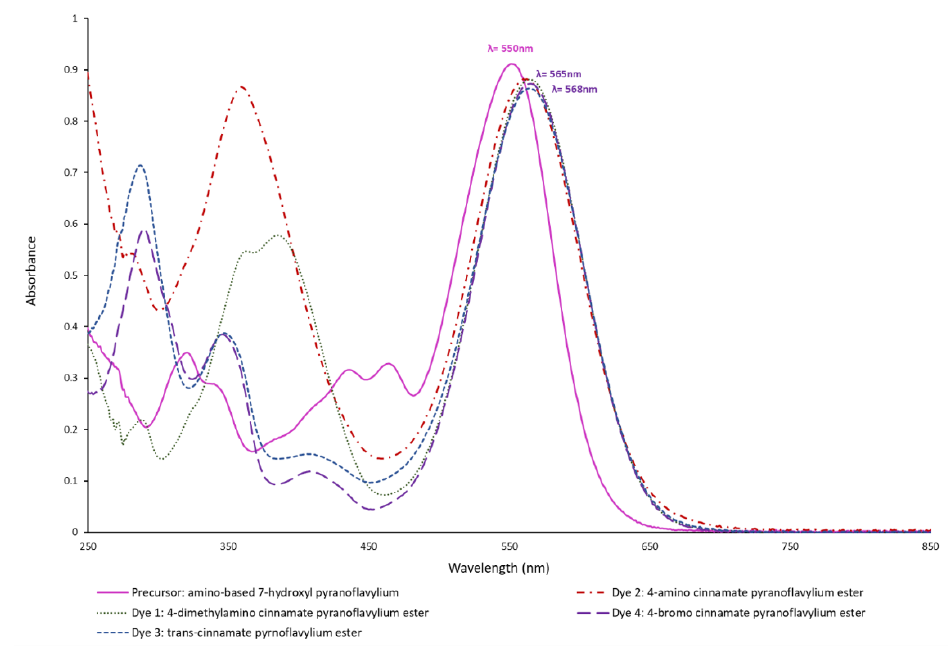
Figure 2. UV-Visible spectrum and maximum absorption wavelength for p -dimethylamino-phenyl- 7-hydroxyl-pyranoflavylium (550 nm) and cinnamate pyranoflavylium esters (565 and 568 nm) recorded from the spectrophotometer in methanol.